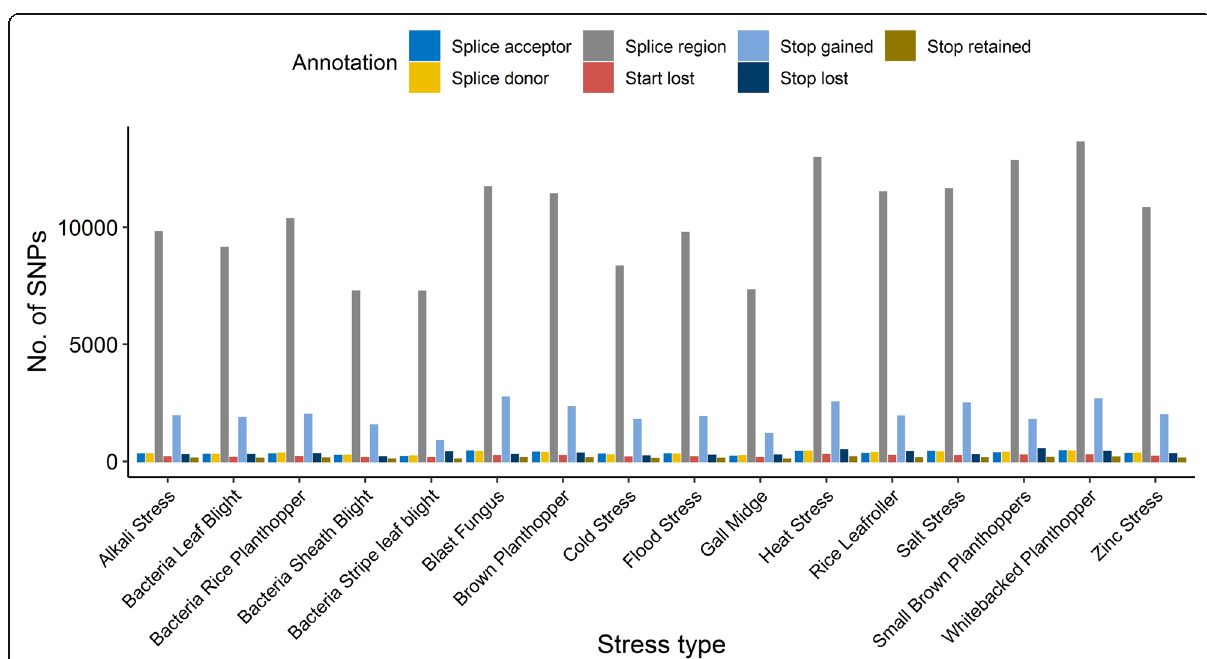
Fig. 3 Number of abiotic and biotic stresses-resistant SNPs in splice region and other large effect SNPs. The large effect SNPs include start/stop gained, lost or retained, and splice donor and acceptor. Start and stop codon gained or lost SNP induce the gain or loss of the start/stop codon. SNP located in the stop codon may retain the stop codon function (Stop codon retained). The SNP generating a splice acceptor, donor or region are named splice acceptors, splice donor of splice